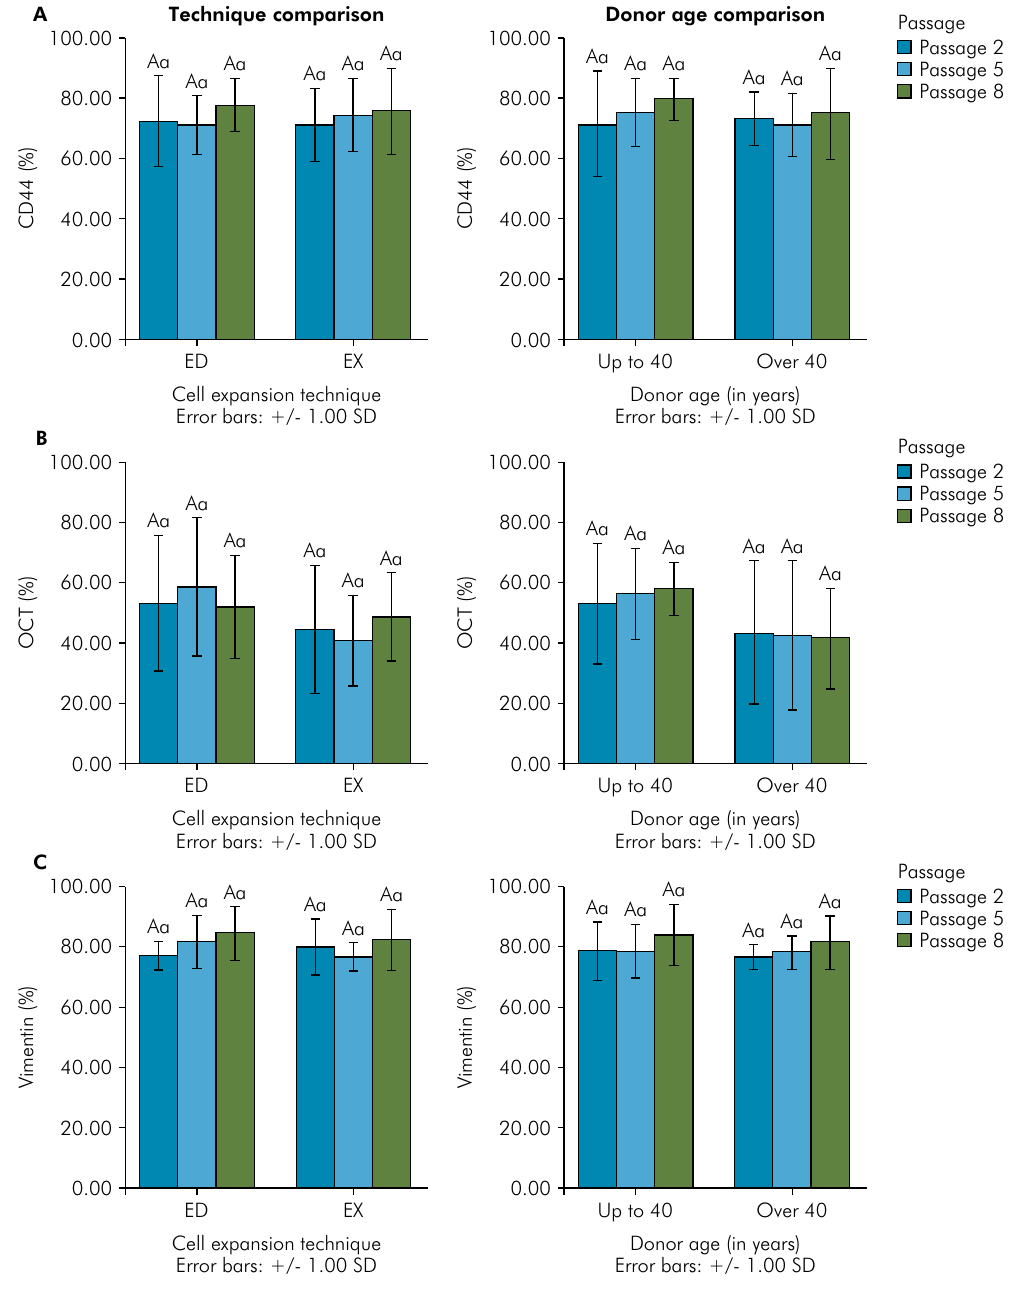
Figure 5. Concentration (%) of dental pulp stem cells (DPSCs) positively marked with CD44 (A), OCT (B) and vimentin (C) in passages 2, 5 and 8.In the left column, cell expansion techniques are being compared, while in the right column, the comparison is between donor age (in years) groups (up to 40/over 40). There was no significant statistical difference detected for all comparisons (ANOVA, p >